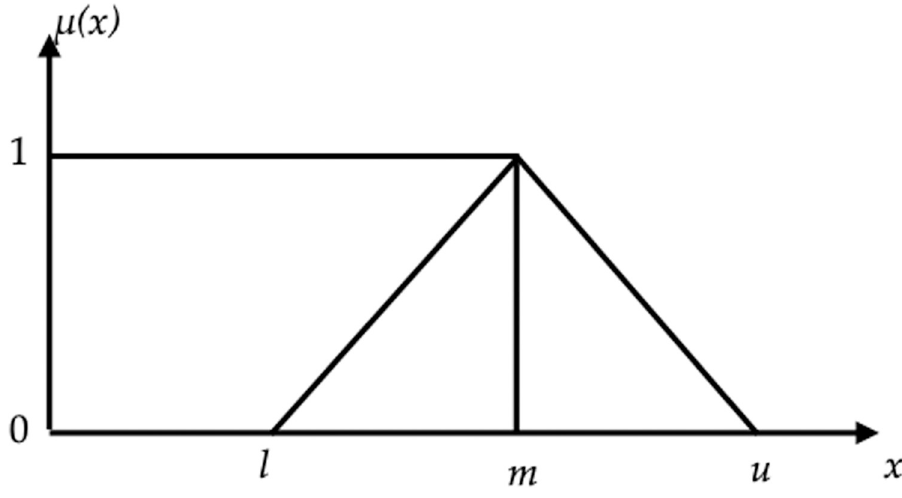
Fig 3. A depiction of TFNs